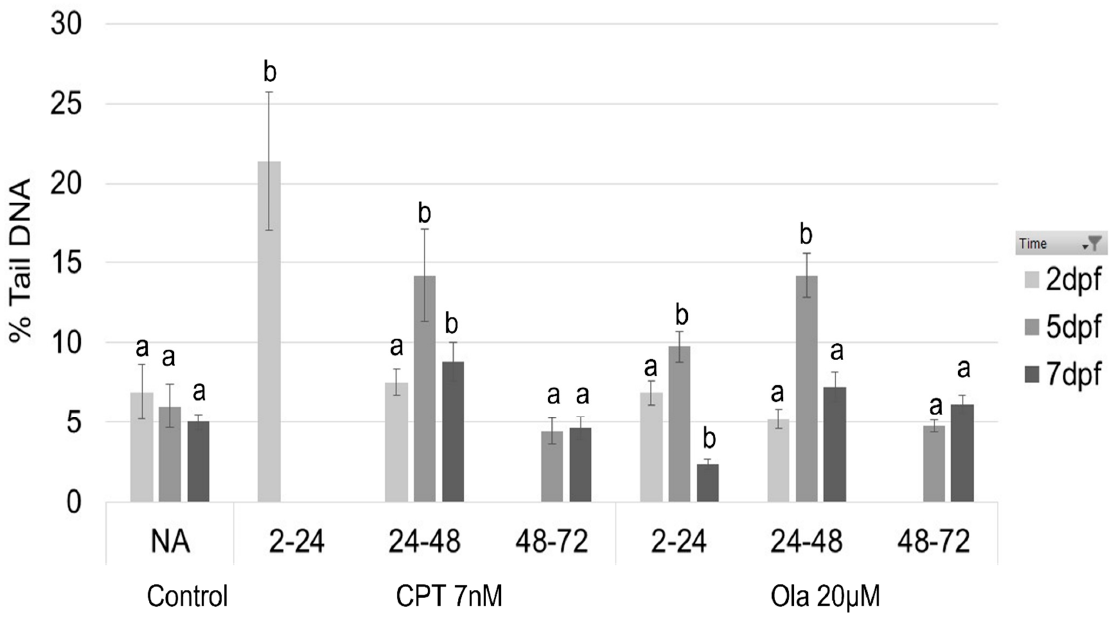
Figure 2. DNA damage analyzed by the comet assay as %TailDNA. Sterlet ( A. ruthenus ) embryos were exposed to CPT and Ola at 2-24, 24-48, and 48-72 hpf. Percentage DNA in the comet tail was analyzed at 2, 5, and 7 dpf. Letters indicate a significant difference between the treatment group and the control at the same dpf (ANOVA, p < 0.05).